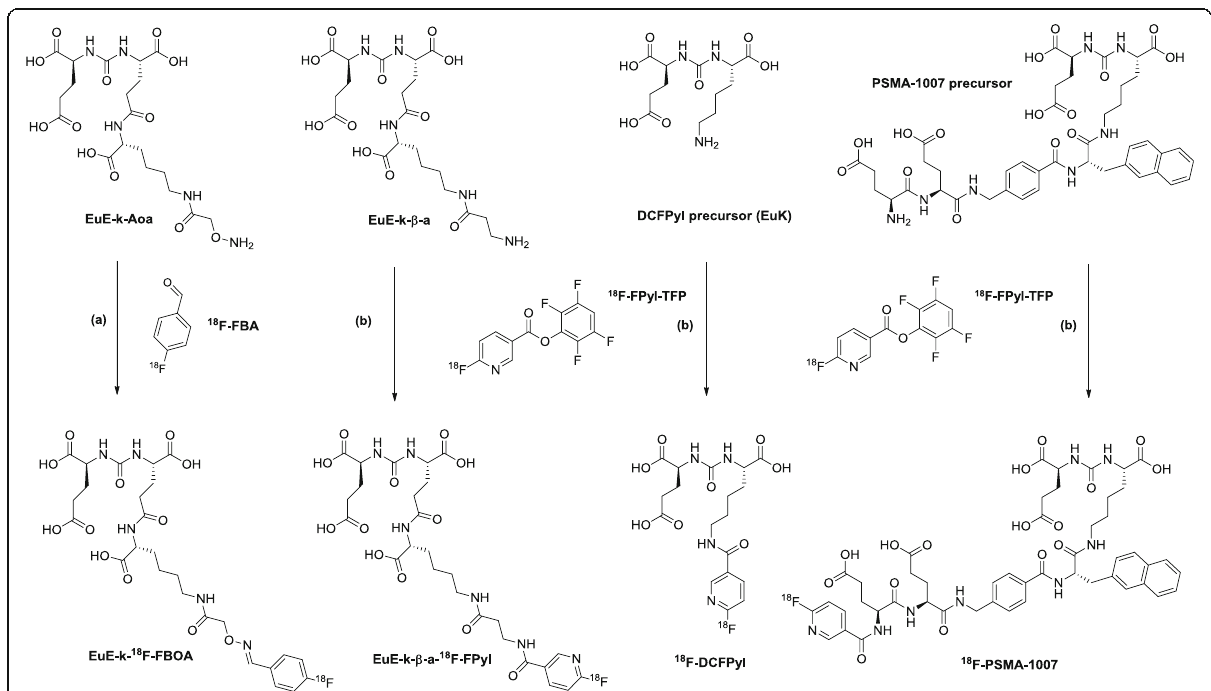
Fig. 1 Synthesis and chemical structures of the 18 F-labeled EuE-based inhibitors (EuE-k- 18 F-FBOA and EuE-k- β -a- 18 F-FPyl), 18 F-DCFPyl and 18 F-PSMA- 1007 [1, 8, 15]. a Reaction conditions: 18 F-FBA, EuE-k-AoA (3.3 μ mol), 15 min at 60 °C [MeCN/water (1/1), ( v /v), acidified with TFA to pH 2.5]. b Reaction conditions: 18 F-FPyl-TFP, EuE-k- β -a/EuK/PSMA-1007 precursor (3.9 μ mol), 15 min at 60 °C, NaHCO 3 (5.5 mg) [MeCN/water; 2/1, ( v / v